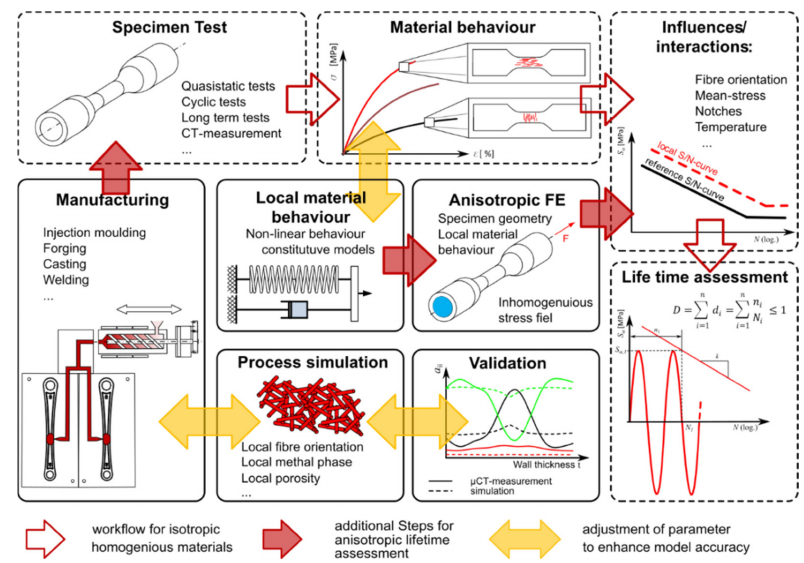
Figure 1. Scheme of the application of the local concept according to